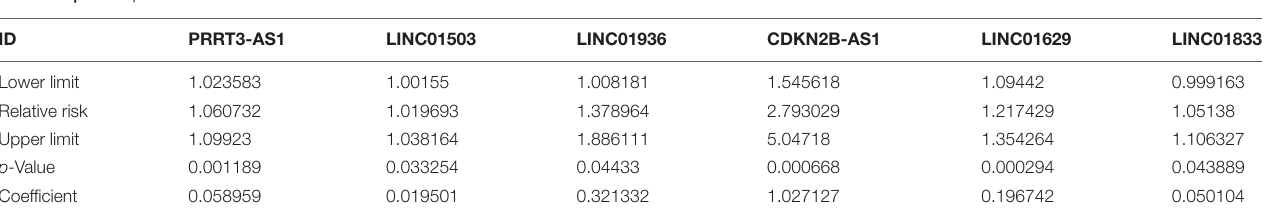
FIGURE 2 | Identification and assessment of the immune-related lncRNA prognostic signature for EC. HR and p -values from univariate Cox (A) and multivariate Cox (B) HR regression of selected genes and immune terms (criteria: p –value < 0.001). TABLE 1 | The expression levels of these six